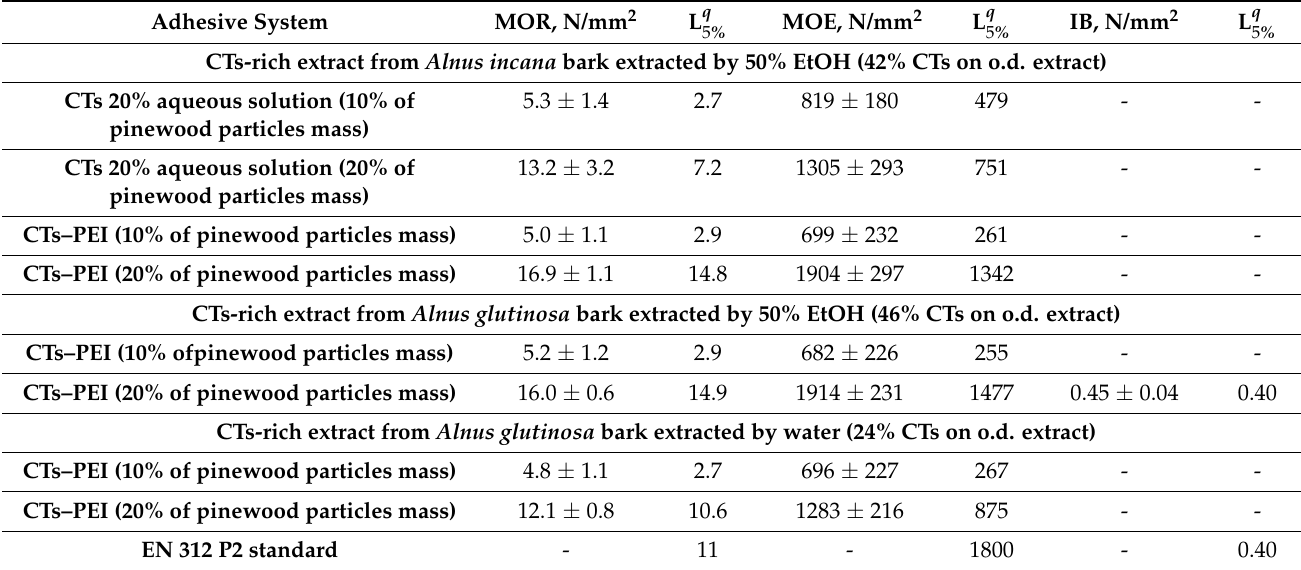
Table 3. The bending properties of particleboard depending on the used adhesive